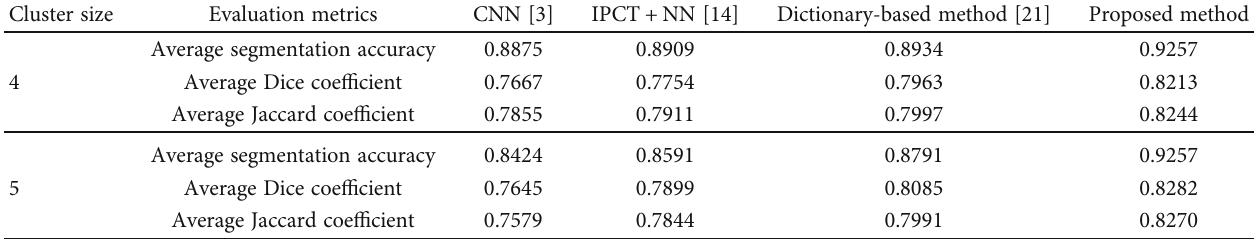
Table 1: Performance comparison of the proposed method with the existing